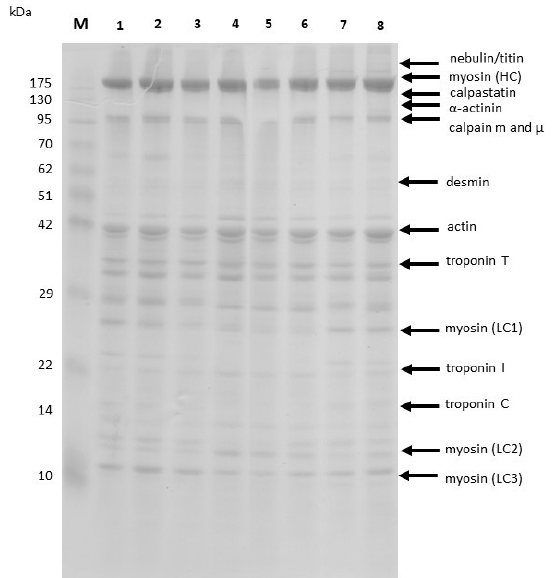
Figure 3. The SDS-PAGE profile of proteins from the aged meat samples; Lane M—marker, Lane 1—control (inside), Lane 2—control (outside), Lane 3—Mf (inside), Lane 4—Mf (outside), Lane 5—control (inside), Lane 6—control (outside), Lane 7—Mf (inside), Lane 8—Mf (outside)